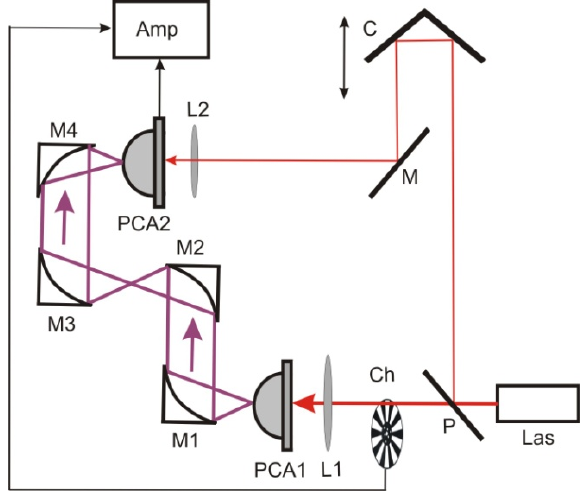
Figure 3. Schematics of the terahertz time-domain spectroscopy setup.